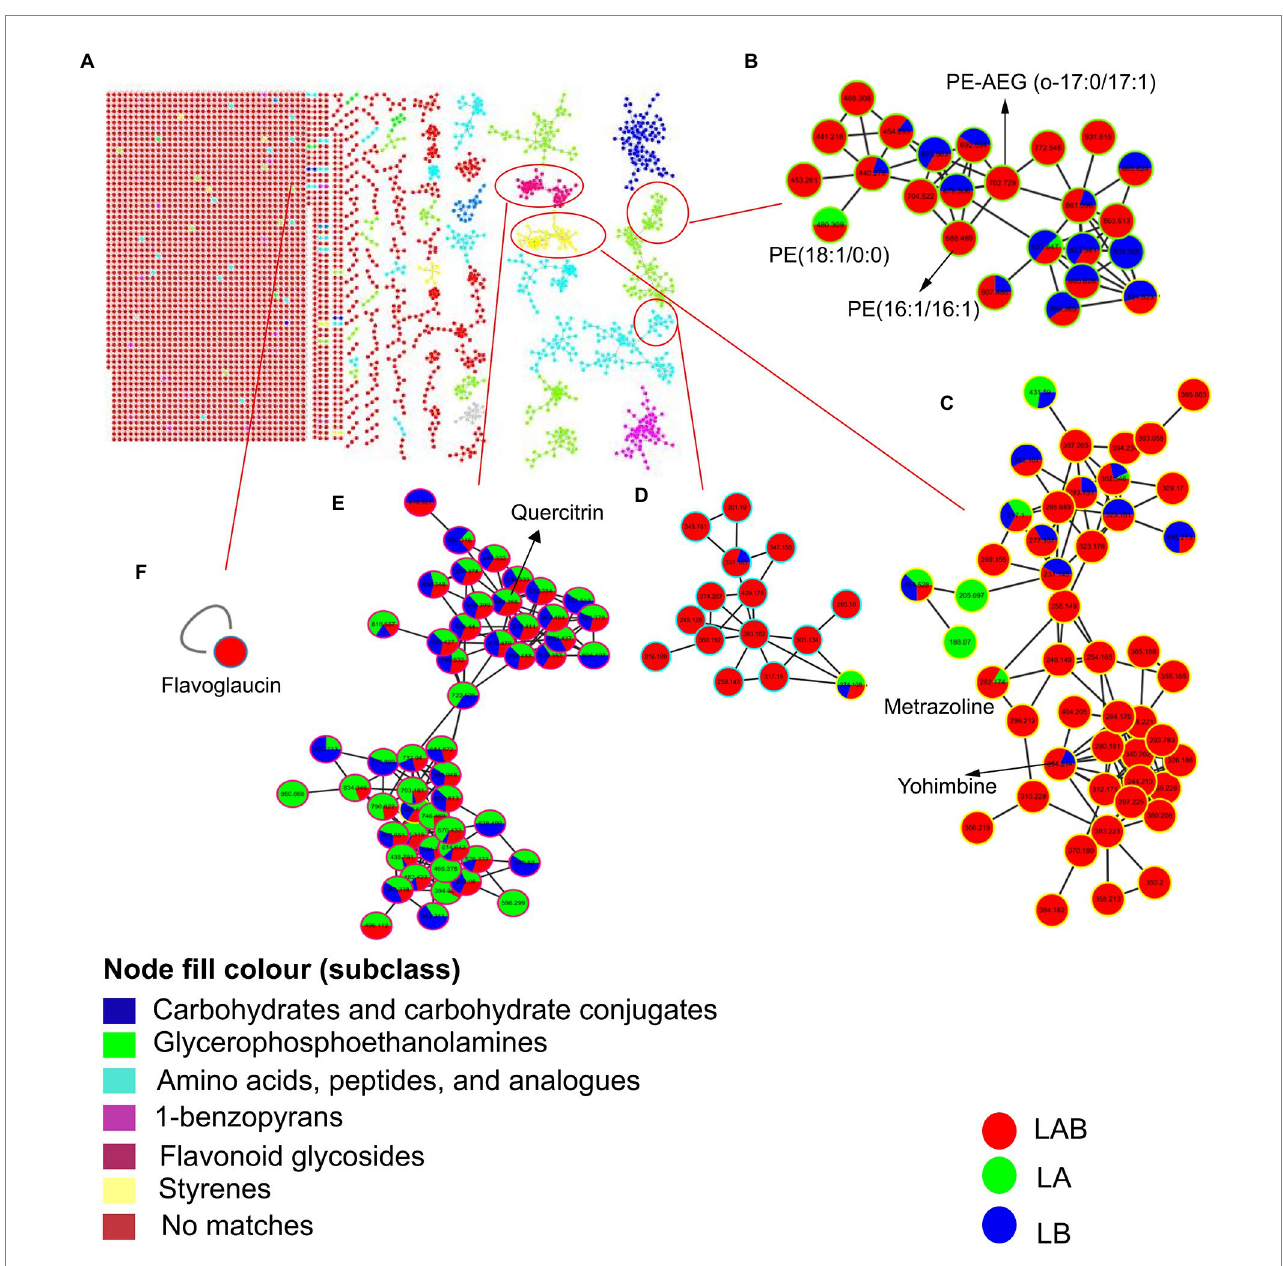
FIGURE 5 Molecular network of the MS/MS spectra for extracellular extracts of E. amstelodami , B. licheniformis pure culture and co-cultures in positive ion mode (A) . Chemical classification was achieved by MolNetEnhancer at the subclass level, (B–E) shows clusters of glycerophosphoethanolamines, styrenes, amino acids, peptides, and analogs and flavonoid glycosides, respectively. (F) Shows a putative flavoglaucin. Nodes represent parent ions and edge thickness corresponds to the cosine score, which represents the degree of similarity between the connected nodes. Pie ratio was determined according to scan number of